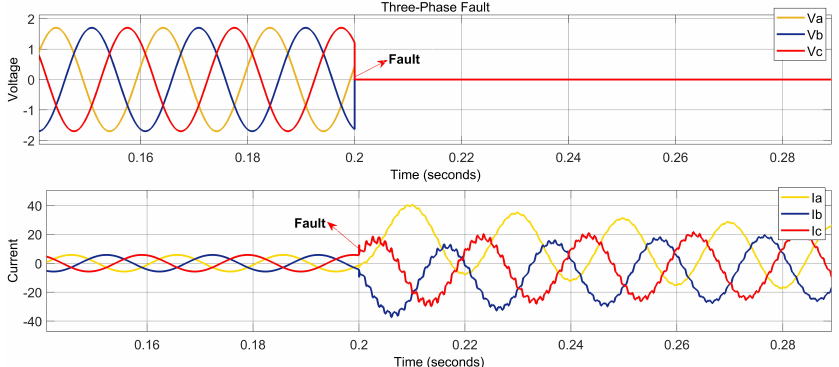
Figure 5. Three-phase to ground fault (a-b-c-g).